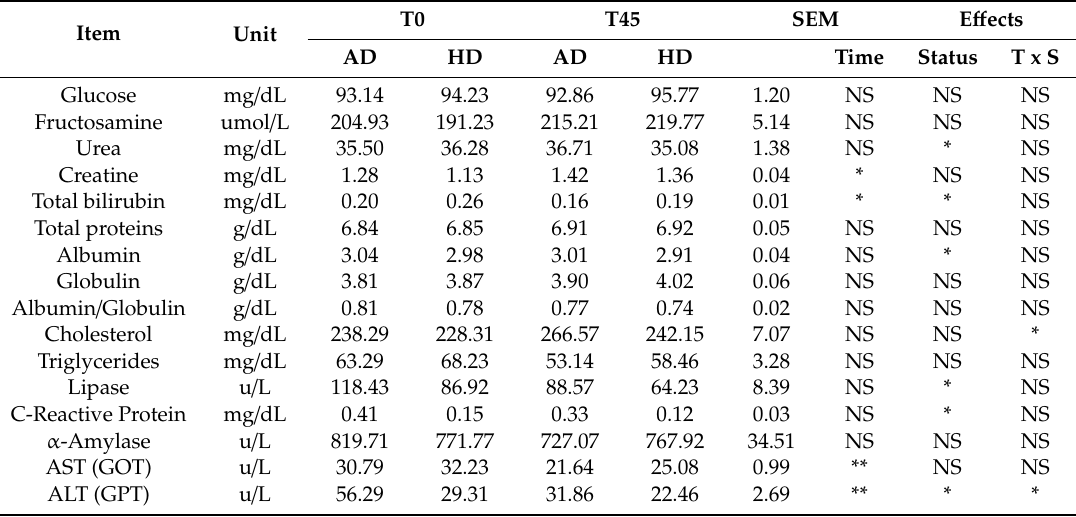
Table 1. Mean concentrations of the parameters determined by blood biochemistry in healthy (HD) and diseased (AD) dogs at the beginning of the study (T0) and after 45 days